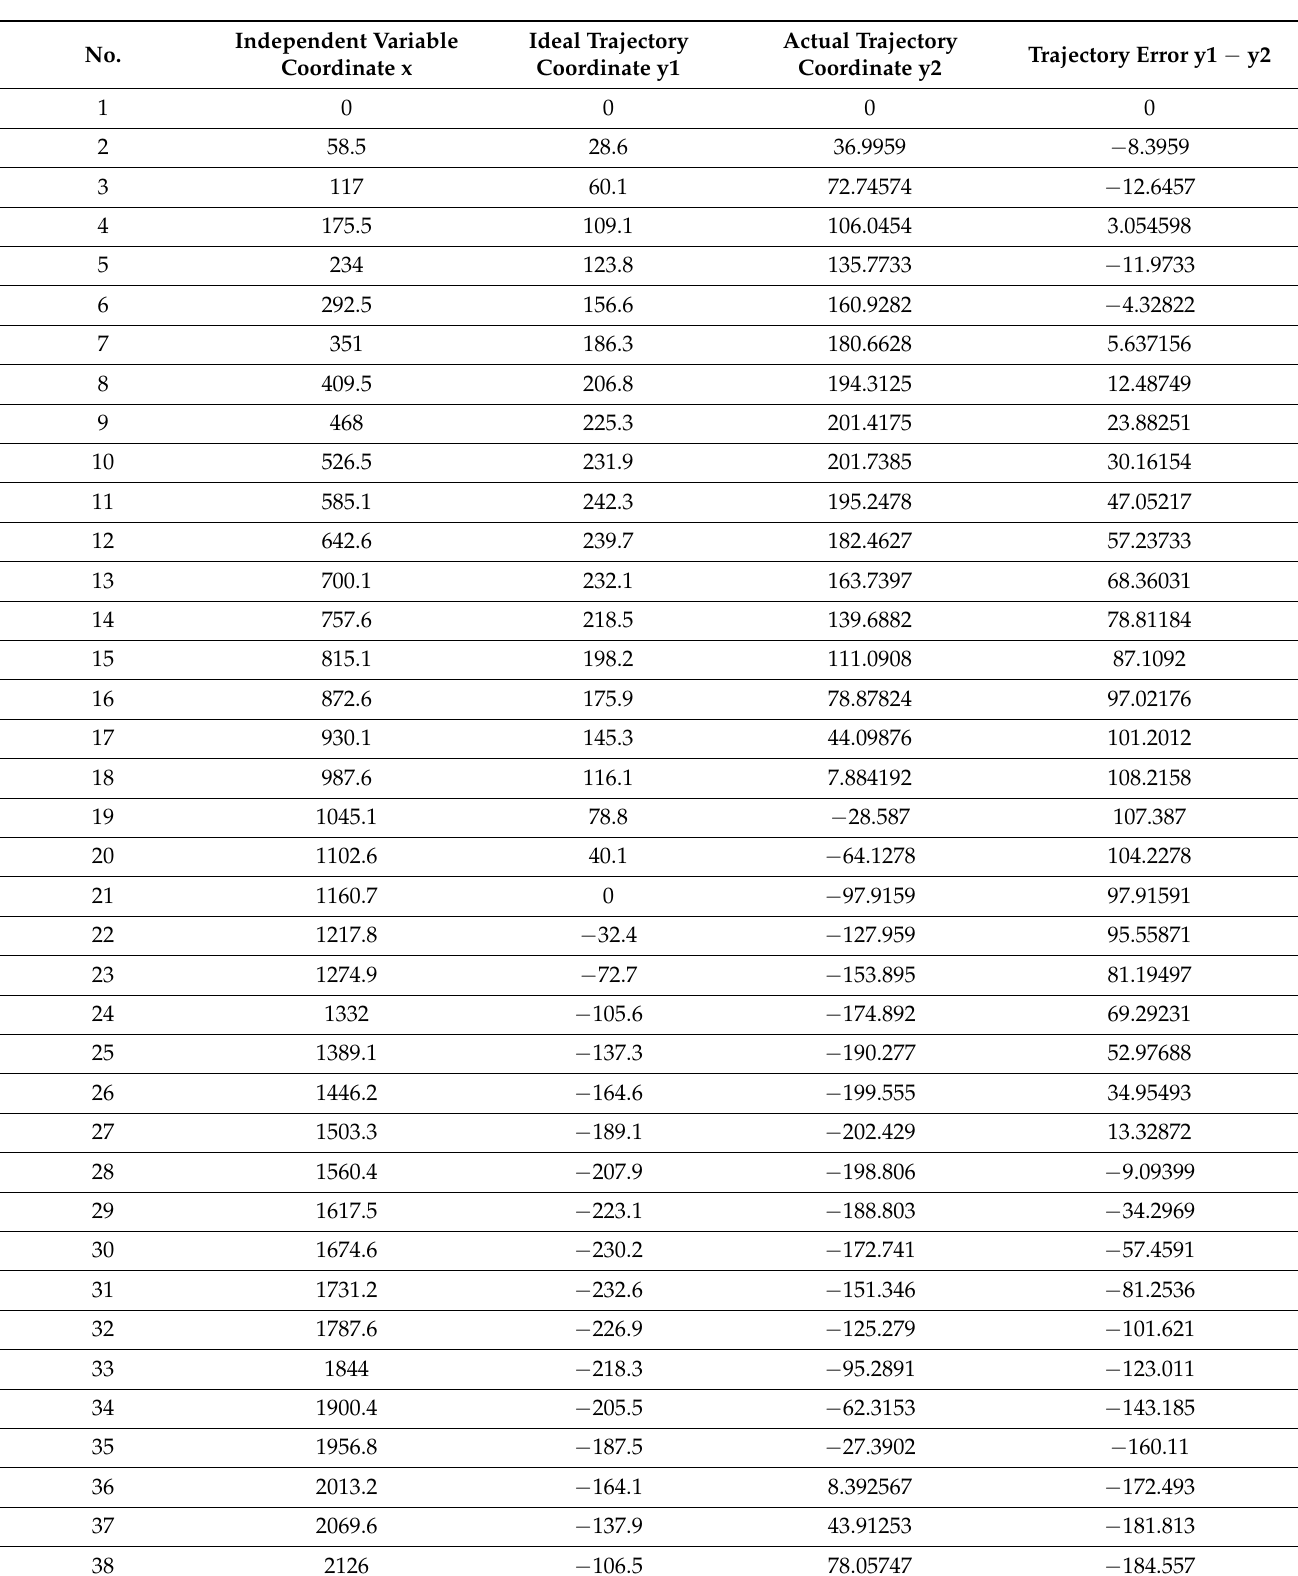
Table A1. Raw trajectory